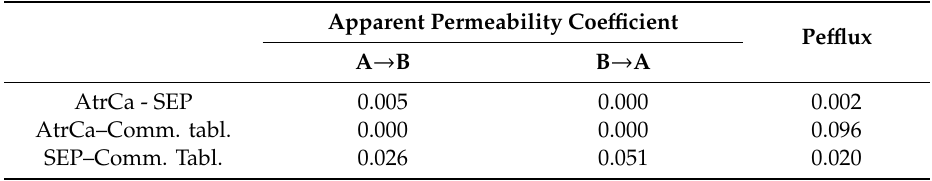
Table 9. Results of the statistical analysis of permeability studies presented as post-hoc multiple comparisons (significance p